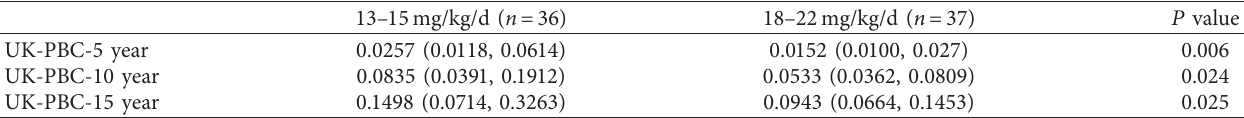
Table 4: UK-PBC risk score.